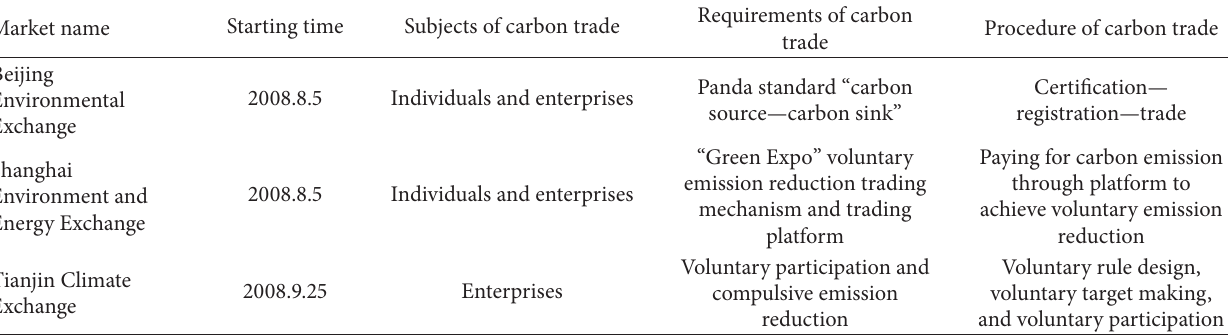
Table 2: Main carbon markets in